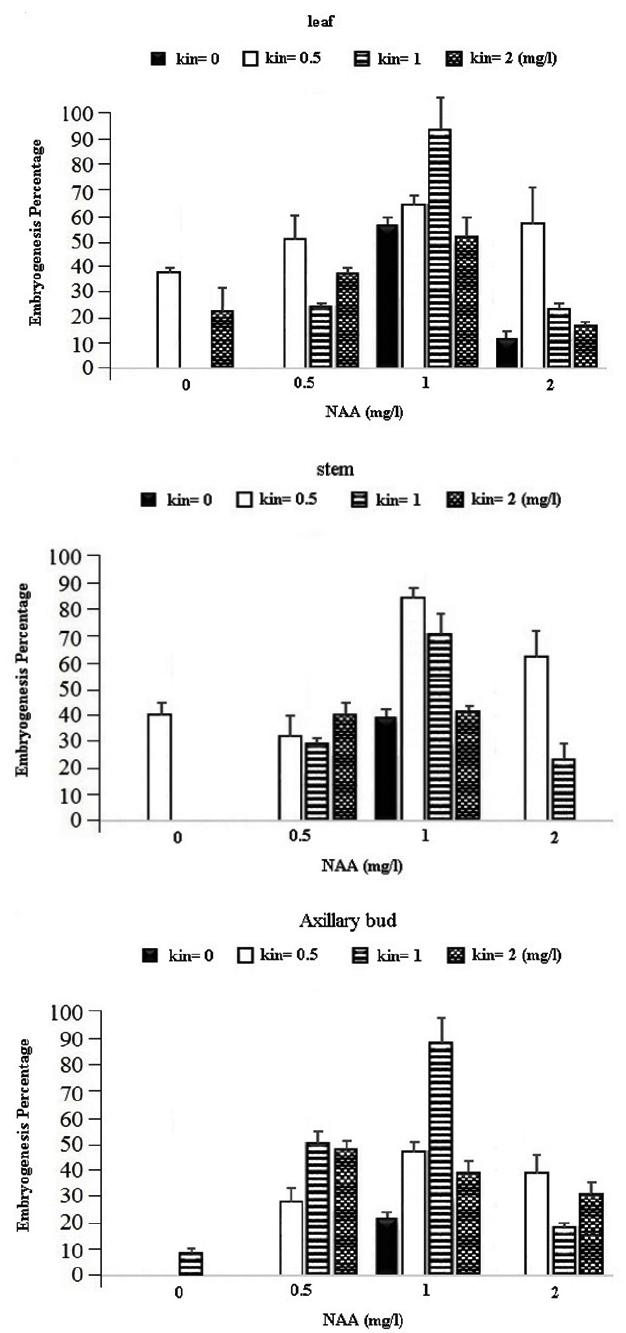
Fig. 1. The effect of Different Concentrations of Growth Regulators (NAA) and Kinetin on Embryogenesis Percentage of Calli Obtained from Explants of Vegetative Parts of the